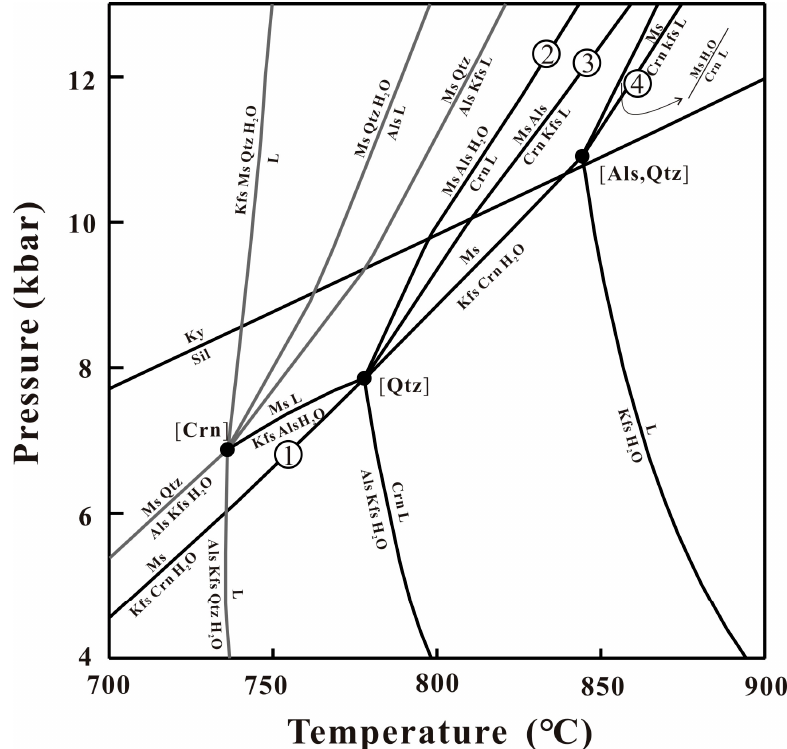
Figure 6. Petrogenetic grid in the system K 2 O-Al 2 O 3 -SiO 2 -H 2 O showing both quartz-present and quartz-absent equilibria. The anomalous positive slope of reaction Ms + L = Kfs + Als + H 2 O that connects the [Qtz] and [Crn] absent invariant points was already documented by [22] and it was explained as the result of uncertainties inherent in the thermodynamic data set; this reaction does not have a significant influence on corundum-bearing rocks. The numbers from 1 to 4 refer to the reactions discussed in the